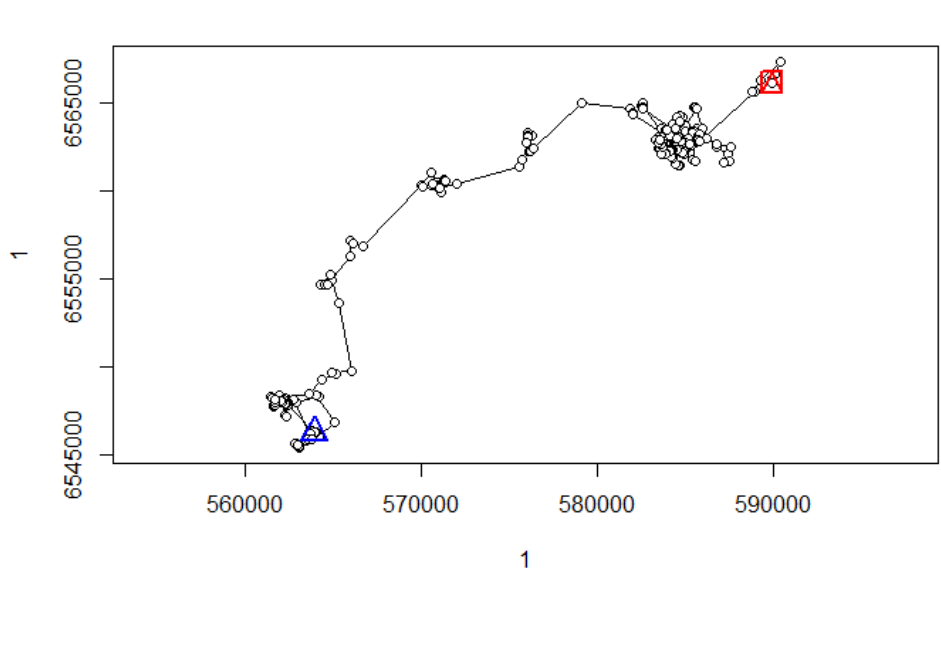
Figure 11: Output of